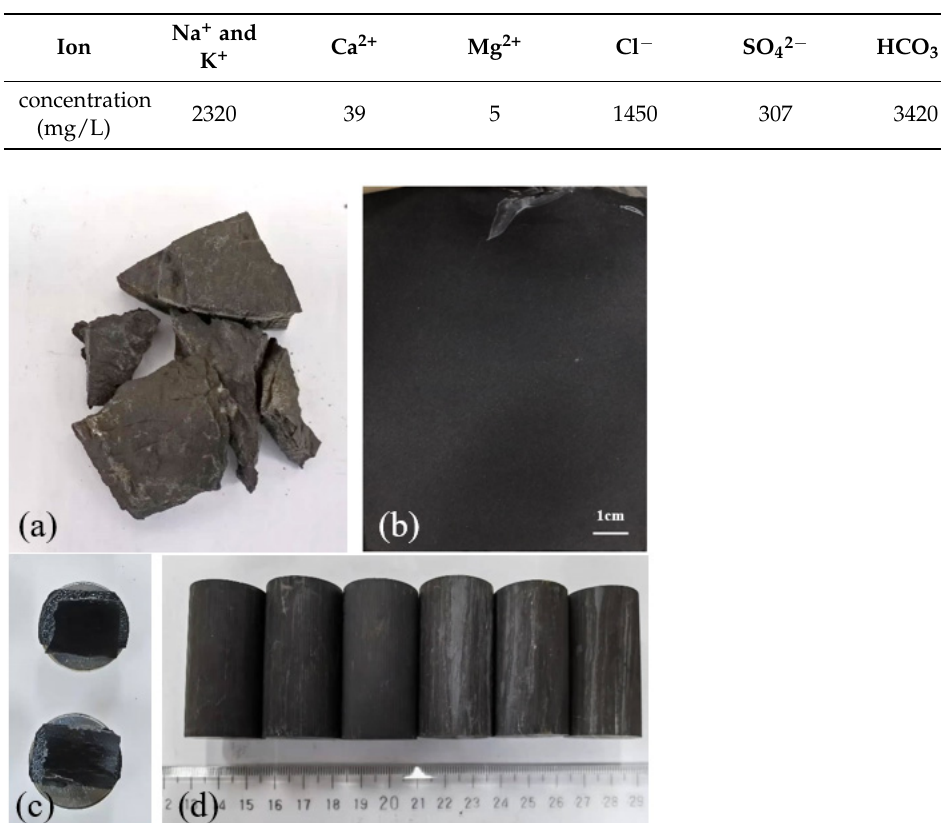
Figure 1. Geographical location of shale samples collection sites. Table 1. Ionic composition of the brine.